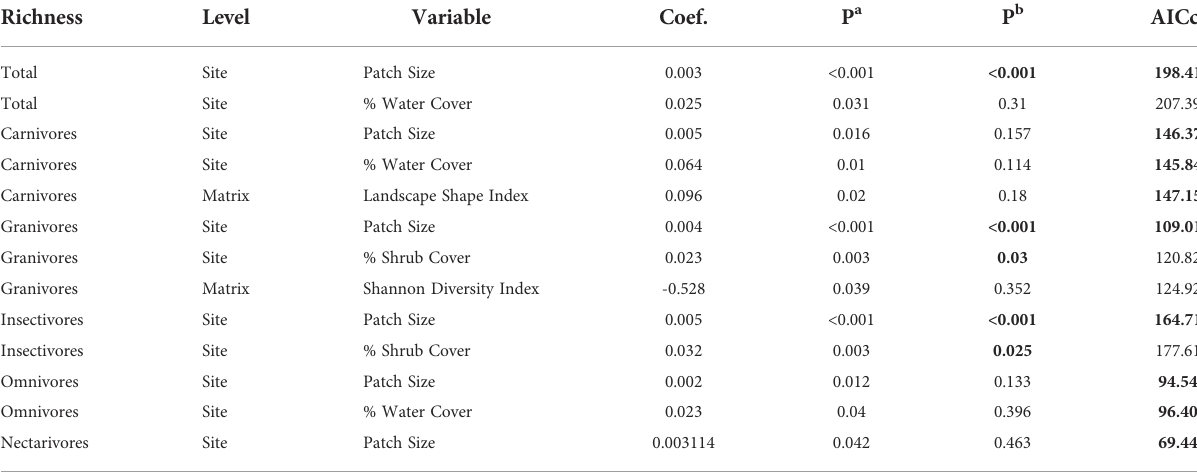
TABLE 4 Results from univariate model analysis quantifying the in fl uence of urban green space (site-level) and urban built form (matrix-level) variables on avian richness in 22 urban green spaces in Los Angeles.